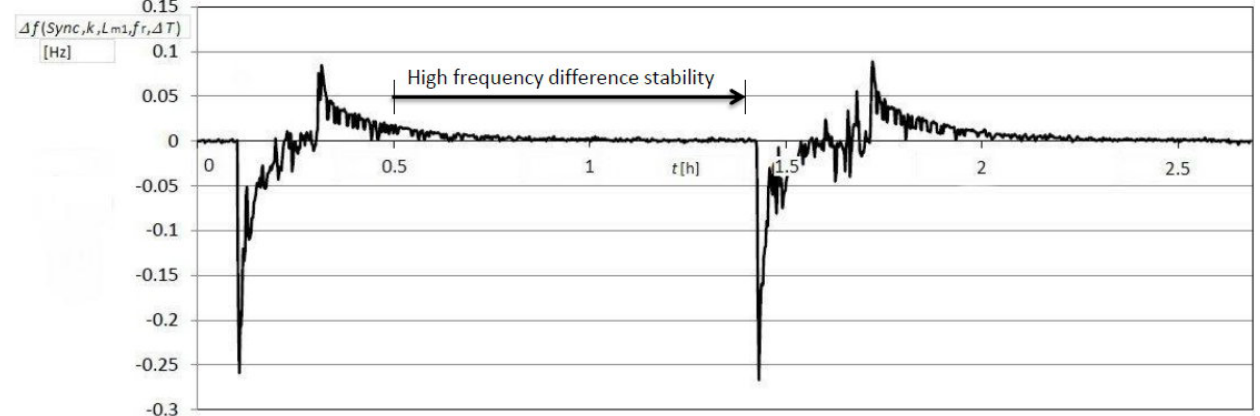
Figure 6. Frequency difference stability (cid:4666)(cid:1858)(cid:4666)(cid:1845)(cid:1877)(cid:1866)(cid:1855), (cid:1863), (cid:1838) (cid:3398)(cid:4666)(cid:1858)(cid:4666) (cid:1845)(cid:1877)(cid:1866)(cid:1855) (cid:3364)(cid:3364)(cid:3364)(cid:3364)(cid:3364)(cid:3364), (cid:1863), (cid:1838) (cid:4667) (cid:3398) (cid:1858) (cid:4667) at the change of temperature in the range 0 °C–50 °C (cid:3040)(cid:2870) (cid:3045) (measurement time 2.5 h—two